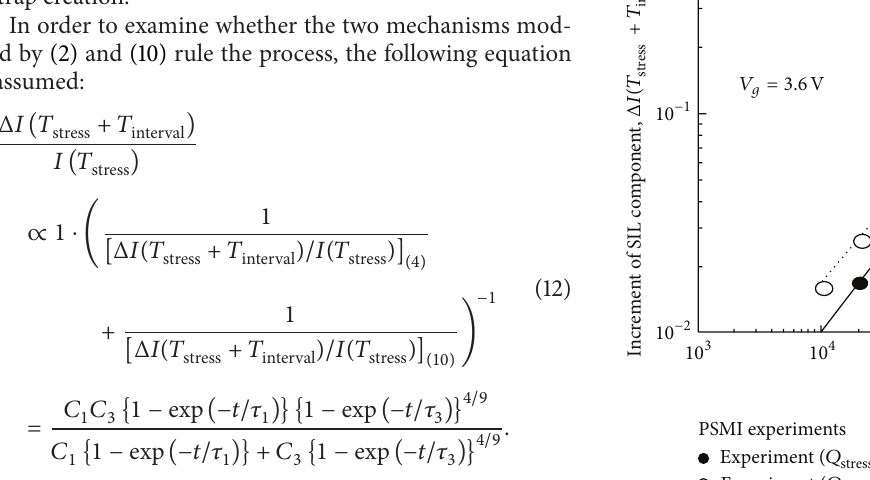
𝑁 > 3.1 × 10 16 [/cm 3 ] (for 𝑄 𝑡